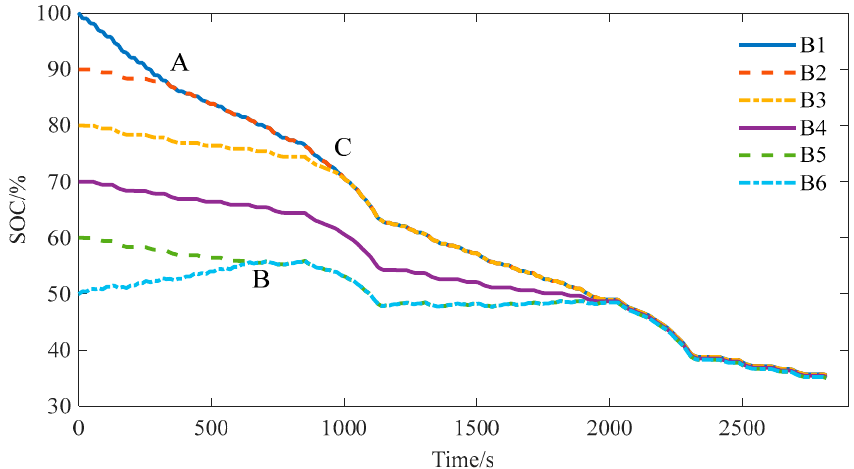
Figure 21. SOC change process under NEDC condition. Table 7. Equilibrium results under NEDC and UDDS